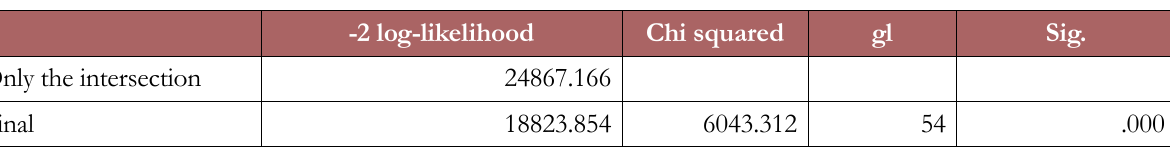
Table 4. Summary of results for estimating the Multinomial Logistic Regression